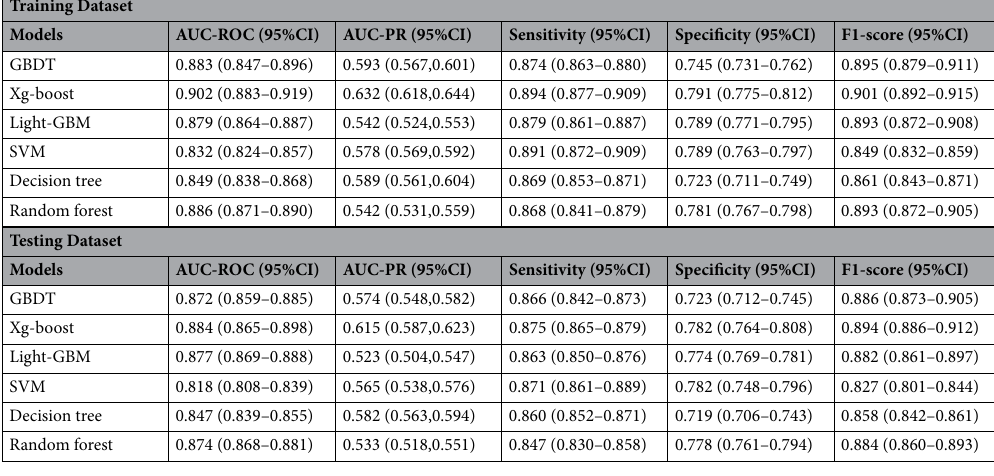
Table 2. Performance evaluation of the different machine learning models in training and testing dataset. CI: Confidence interval; AUC: area under the receiver operating characteristic